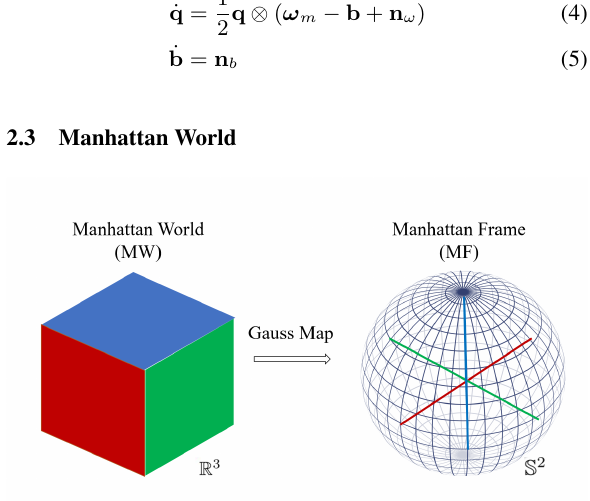
Figure 2. The MW can map to a unit sphere in the surface normal